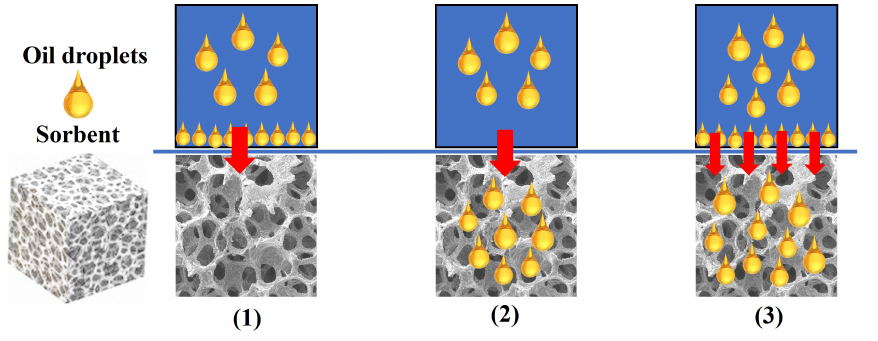
Figure 3. Schematic diagram of oil absorption process. (1) oil droplets accumulate on the surface of sorbents via weak interaction forces; (2) oil droplets penetrate the intermolecular of sorbents under the capillary forces; (3) both the surface accumulation and intermolecular penetration